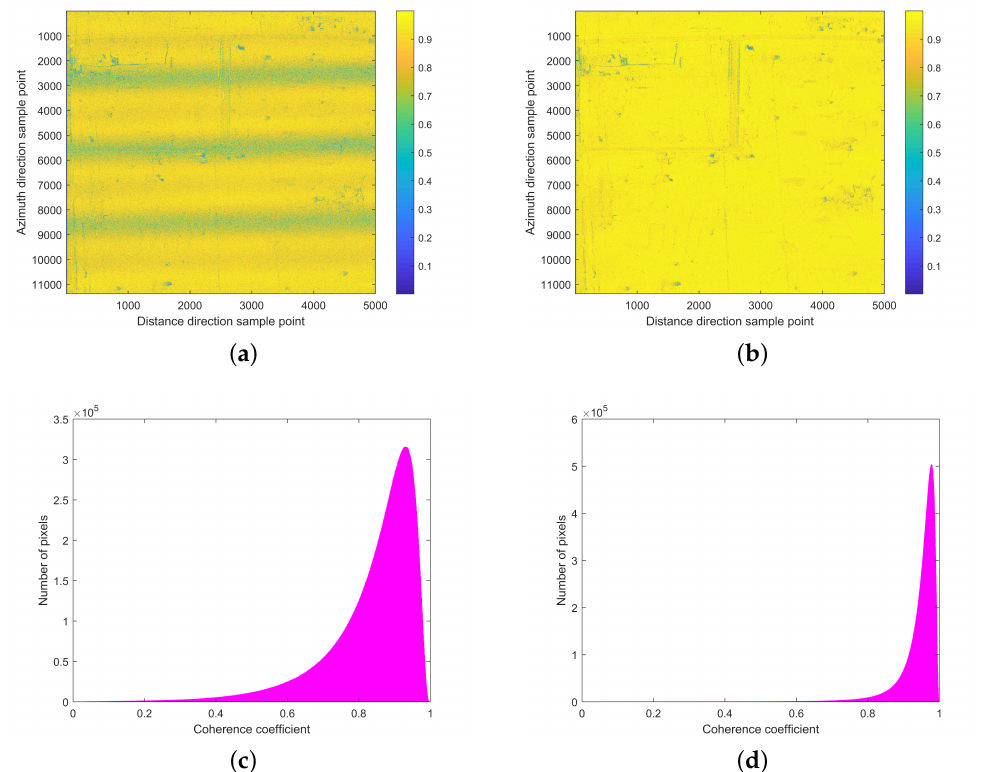
Figure 10. The comparison results. ( a ) The comparison method’s coherence coefficient diagram; ( b ) the proposed method’s coherence coefficient diagram; ( c ) the comparison method’s coherence coefficient statistical histogram; ( d ) the proposed method’s coherence coefficient statistical